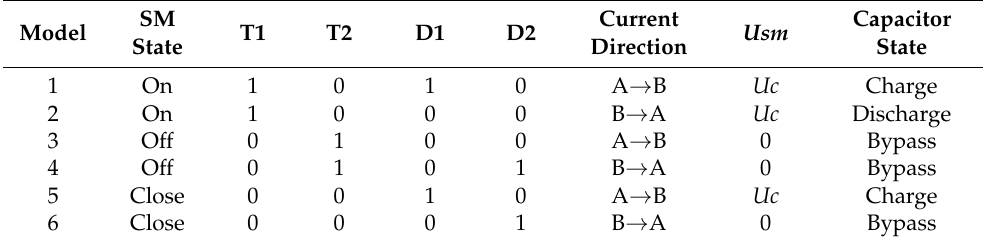
Table 1. Working status of the